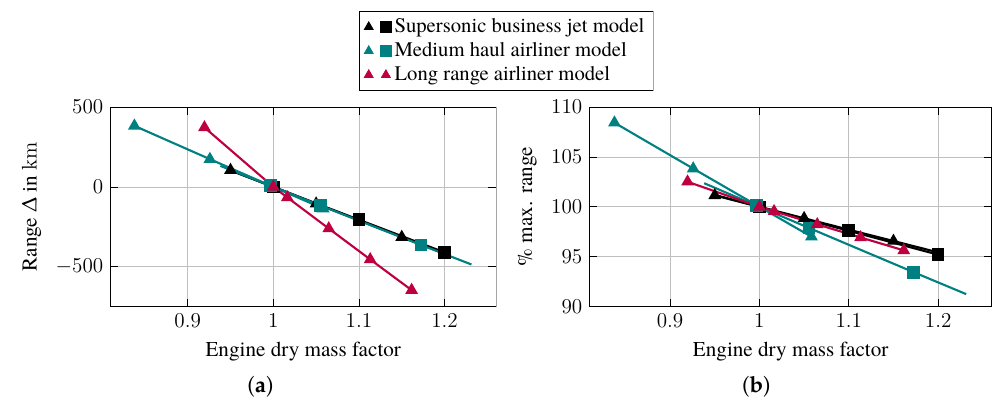
Figure 9. Engine dry mass and aircraft range exchange rates for different types of aircraft: ( a ) absolute changes; ( b ) relative changes.